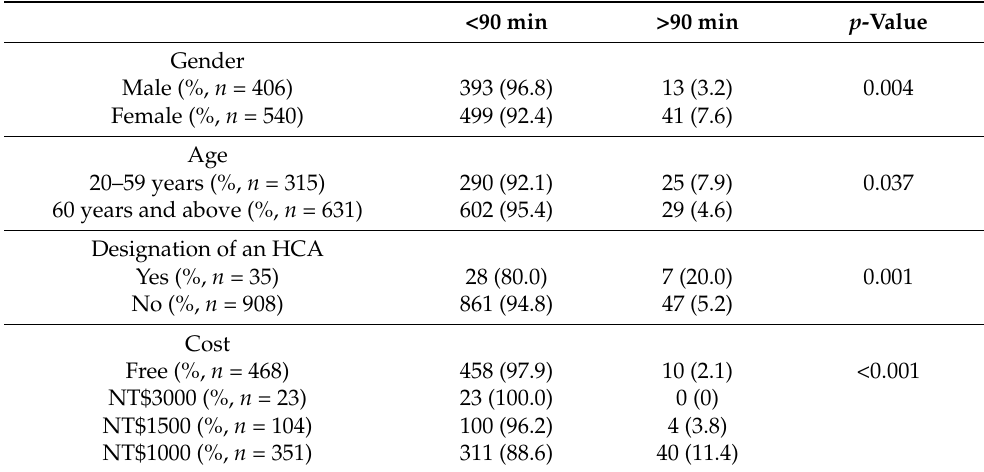
Table 4. The time required in advance care planning in Taipei Veterans General Hospital in